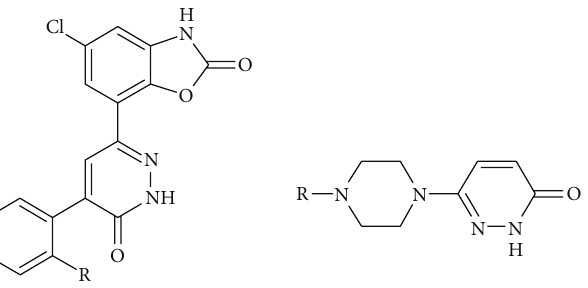
Scheme 13: BB3 AG 246, FR8 FR10 CM8, and AG 246 CF8 reported some pyridazine-containing structures with analgesic and anti- inflammatory